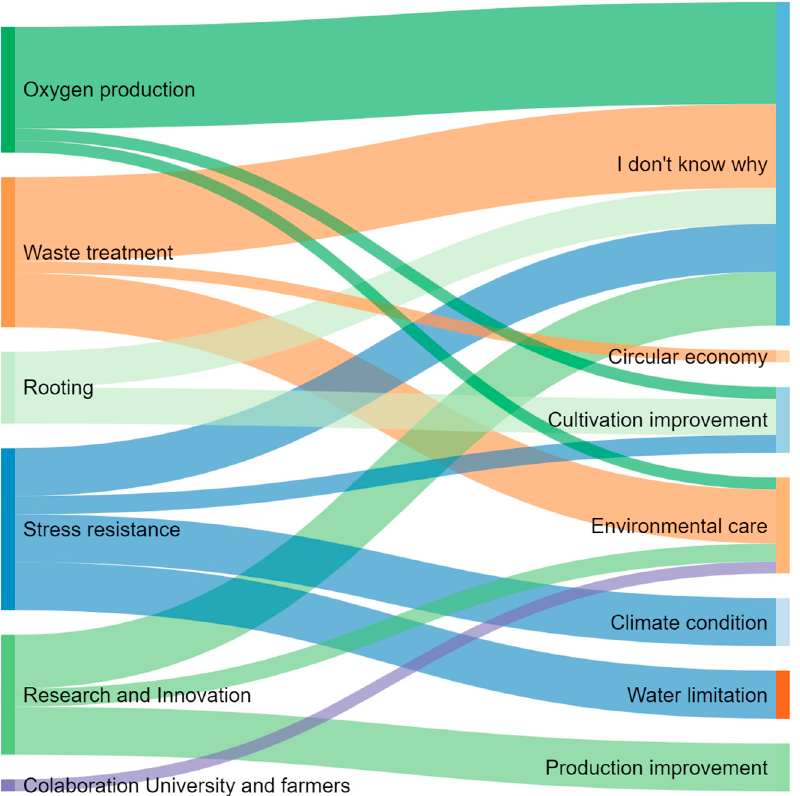
Figure 5. Associations between microalgae applications in agriculture and farmers’ motivations.